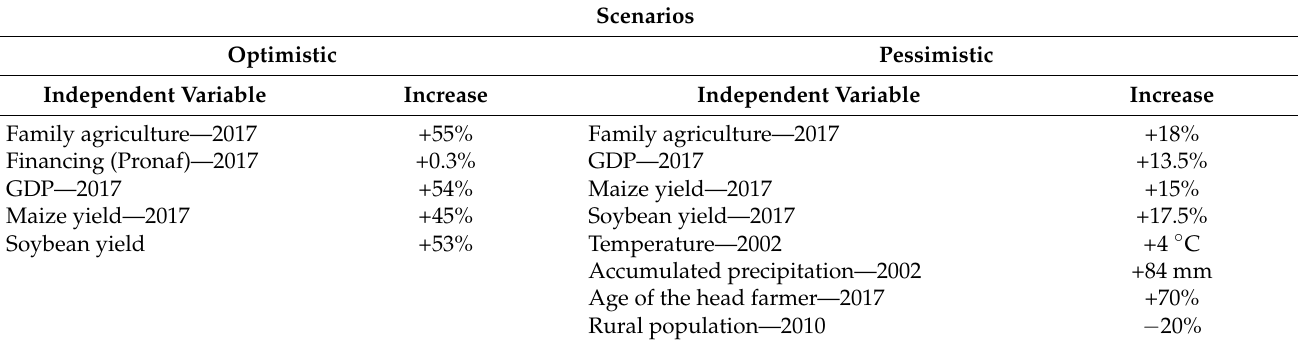
Table 6. Increase in the independent variables used for the construction of optimistic and pessimistic